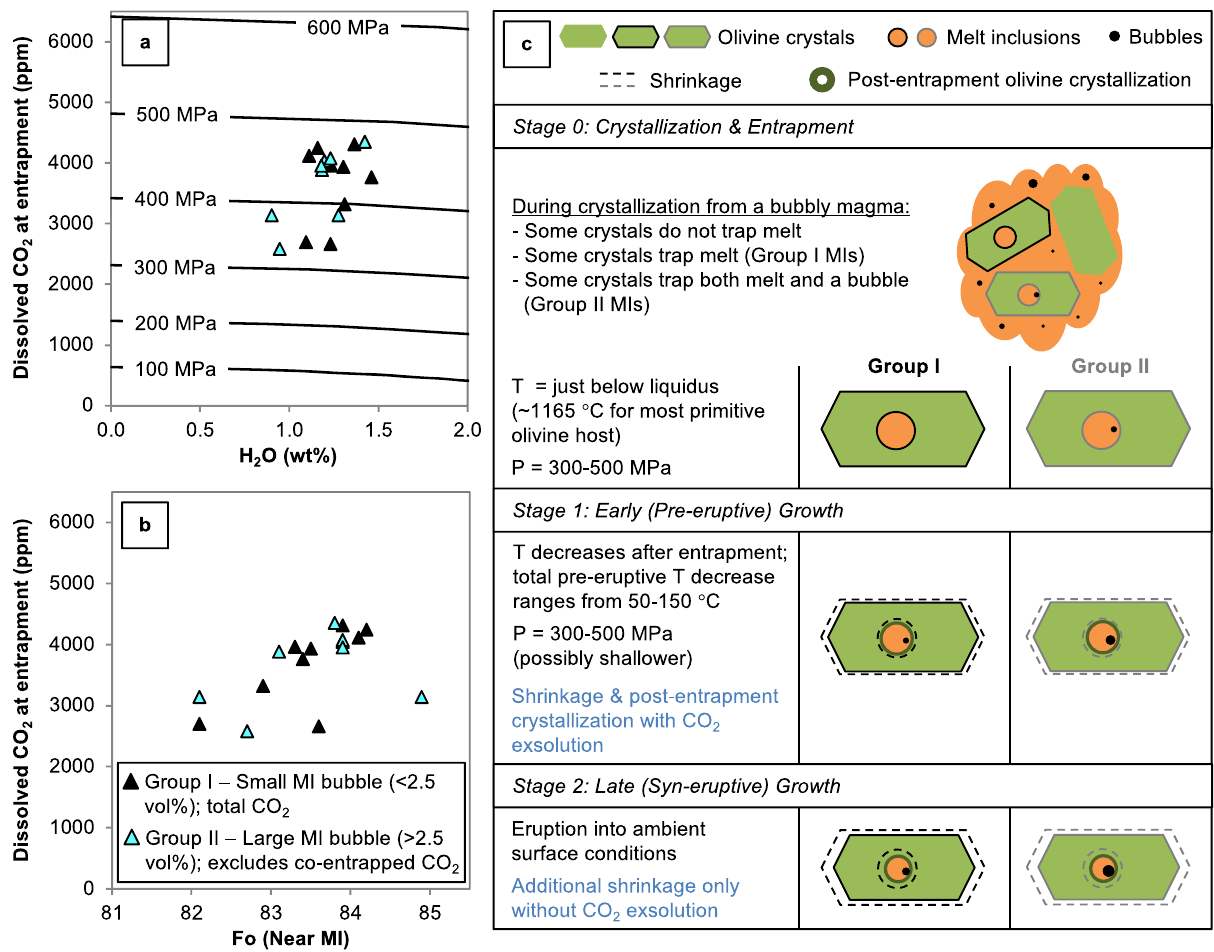
Fig. 4 Conditions at MI entrapment and conceptual model of MI bubble growth. a , b Dissolved CO 2 in the Sunset Crater magma at the time of MI entrapment. Group I samples ( fi lled symbols) are plotted with their total CO 2 (glass + bubble). For Group II samples (cyan symbols), total CO 2 content is calculated assuming that 35% of the originally dissolved CO 2 content is sequestered into a bubble. a H 2 O – CO 2 of MIs; curves are isobars from ref. 32 . b Dissolved CO 2 at entrapment vs. Fo content of the olivine host measured next to the MI. Error from FTIR analysis is 10% for H 2 O and 5% for CO 2 , while the error in the total CO 2 content from bubble calculations is 5%. Error in MI bubble vol% is 15% (i.e., 0.3 vol% error for a 2 vol% bubble). See “ Methods ” for details on error estimates. c Interpretation of MI entrapment and bubble growth in MIs in the Sunset Crater magma. The modi fi cations to the MIs shown are cumulative from the entrapment